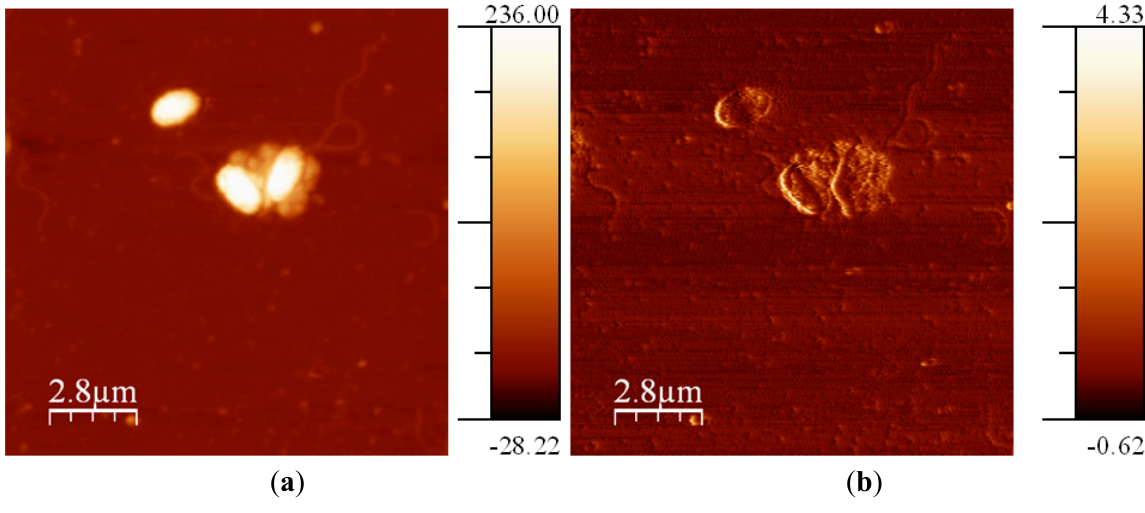
Figure 8. ( a ) Topography image of bacteria acquired in amplitude modulation (Z scale